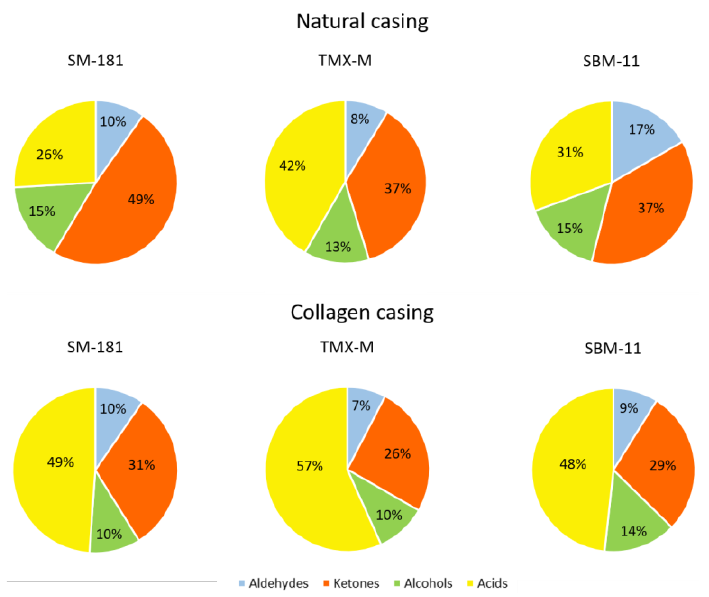
Figure 2. Percentage of volatile compounds grouped based on their chemical structure (aldehydes, ketones, alcohols and acids) detected in the different samples at the end of ripening.